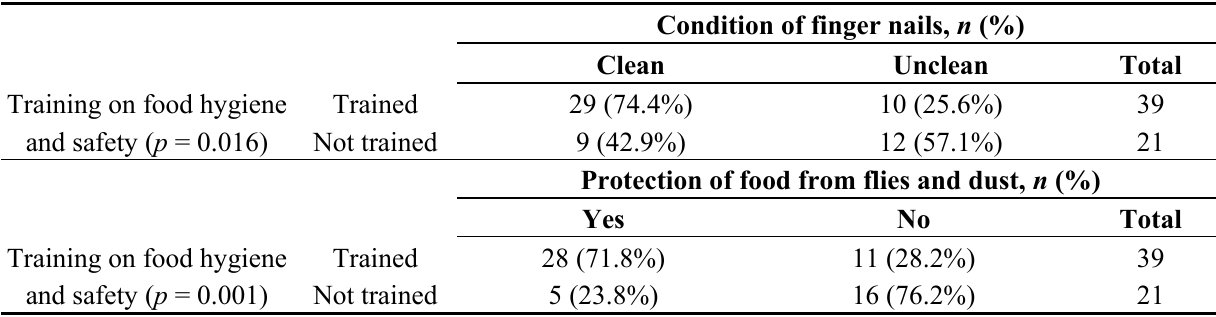
Table 6. Relationship between training on food hygiene and safety, cleanliness of fingernails and extent of food protection among food